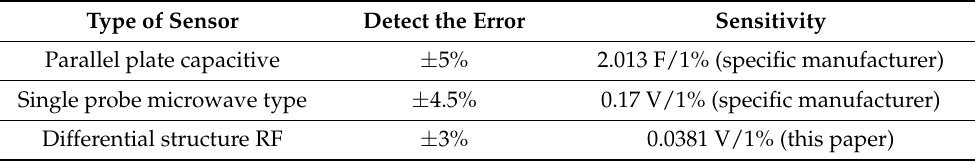
Table 9. Comparison of the sensor detection parameters of different